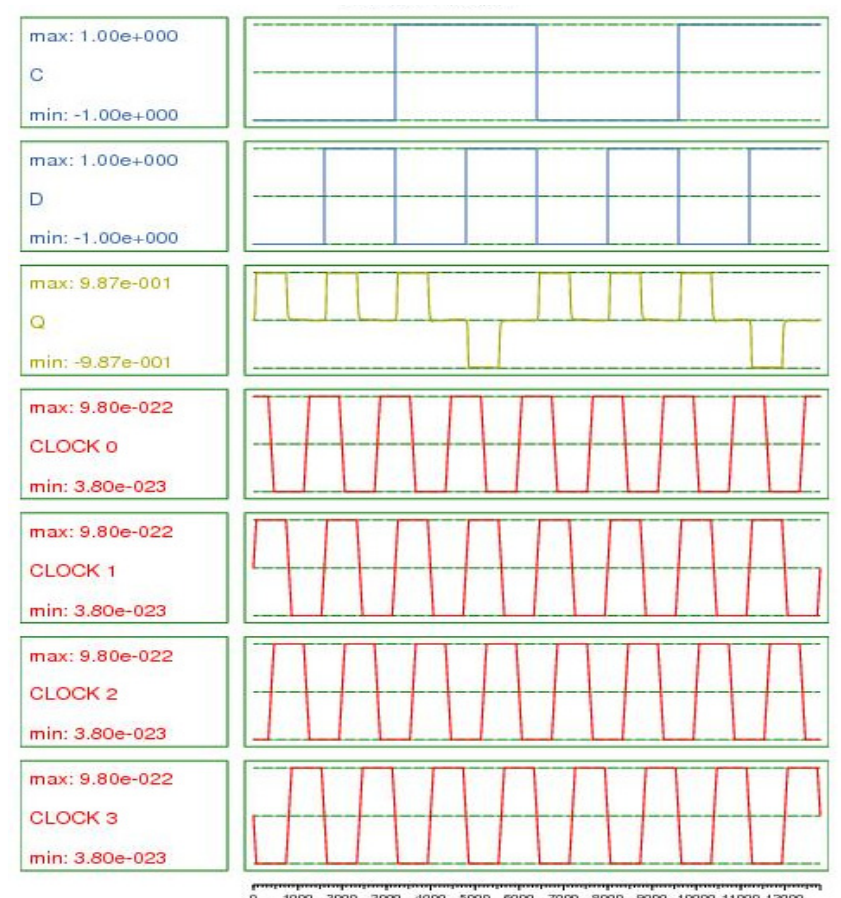
Figure 9. Simulation graph of proposed DFF.